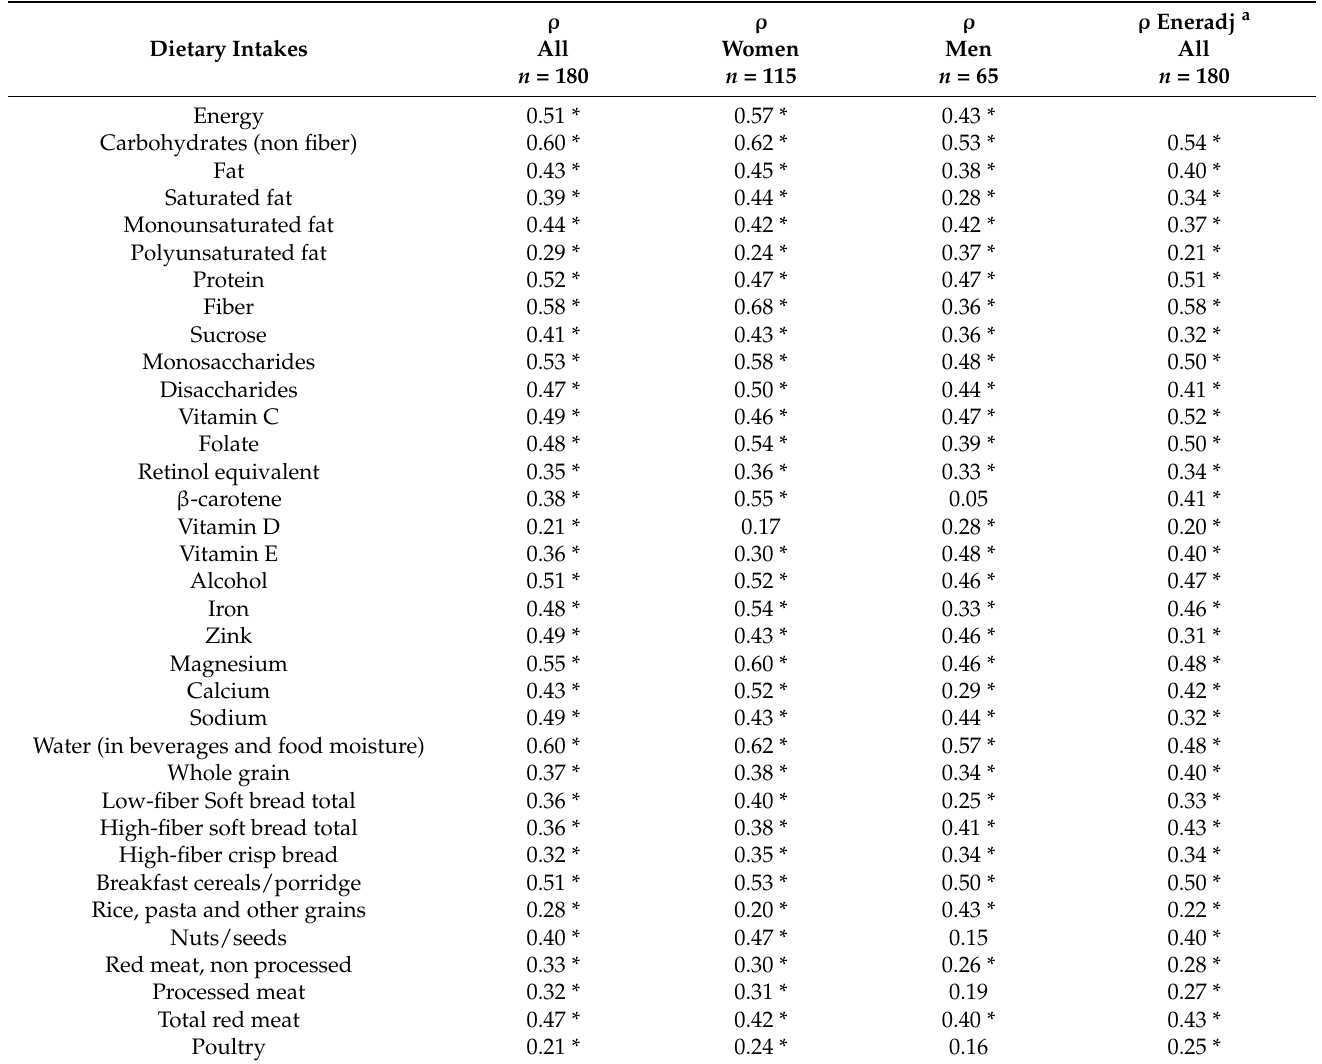
Figure 2. Correlations between 4DFR and SFFQ based on baseline vs. mean of baseline and repeated measurements. Stronger correlations were observed between the two methods for all intakes based on mean of baseline and repeated measurements (2 × 4DFR and 2 × SFFQ) compared to correlations between baseline measurements only, especially regarding specific vegetables, soft bread and fatty fish. Data from individuals with repeated dietary measurements in the Malmö Offspring Study ( n = 180). Table 3. Spearman correlations between dietary intakes from the first and repeated 4-d food record (4DFR) (g/d) in the Malmö Offspring Study ( n =